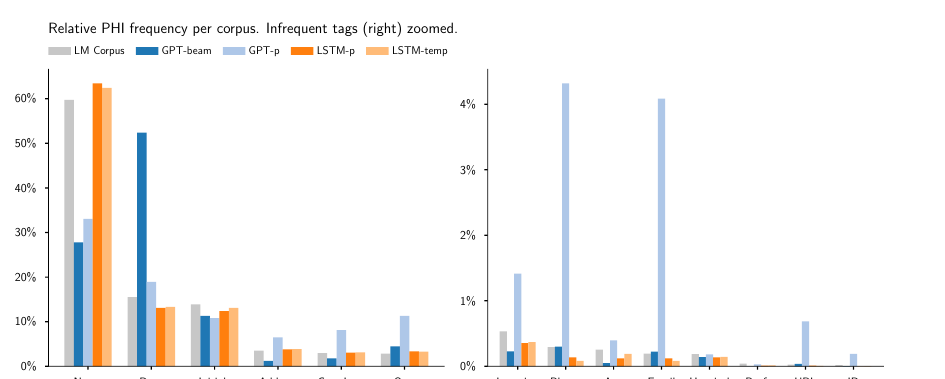
Figure A1. PHI distribution of the synthetic corpora compared to the language modeling corpus.